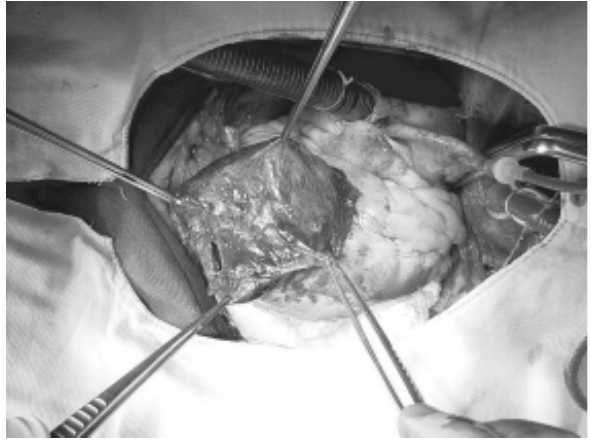
Fig. 1 - Aneurisma em parede anterior de ventrículo esquerdo roto